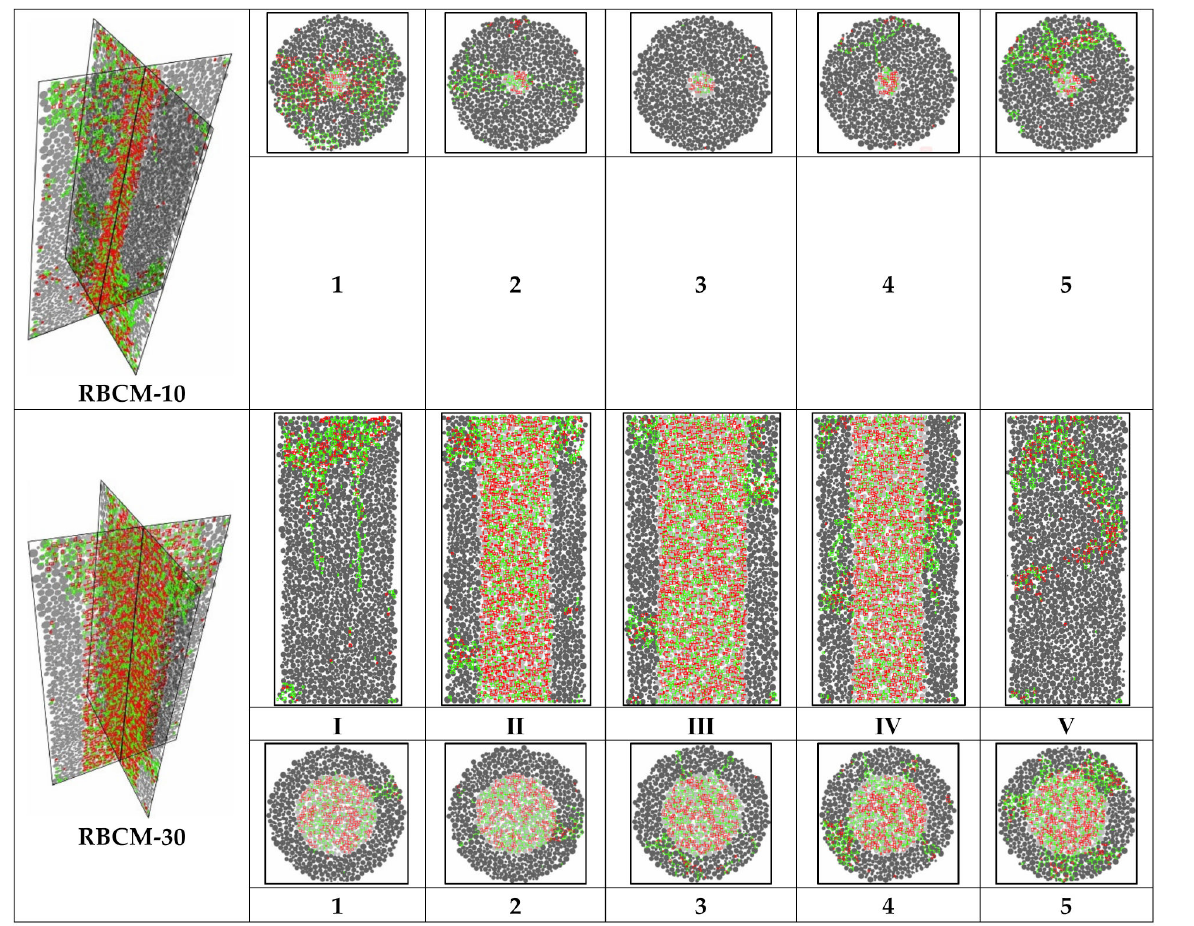
Figure 16. Spatial distribution of the cracks after the samples’